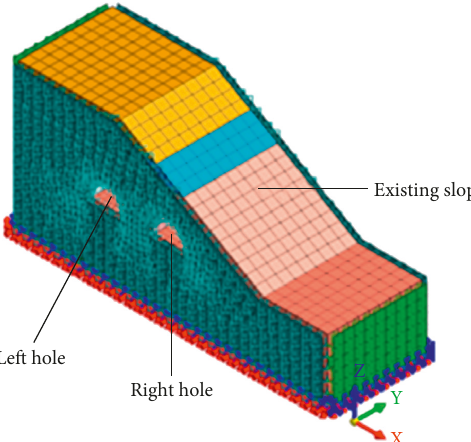
Figure 1: Numerical calculation